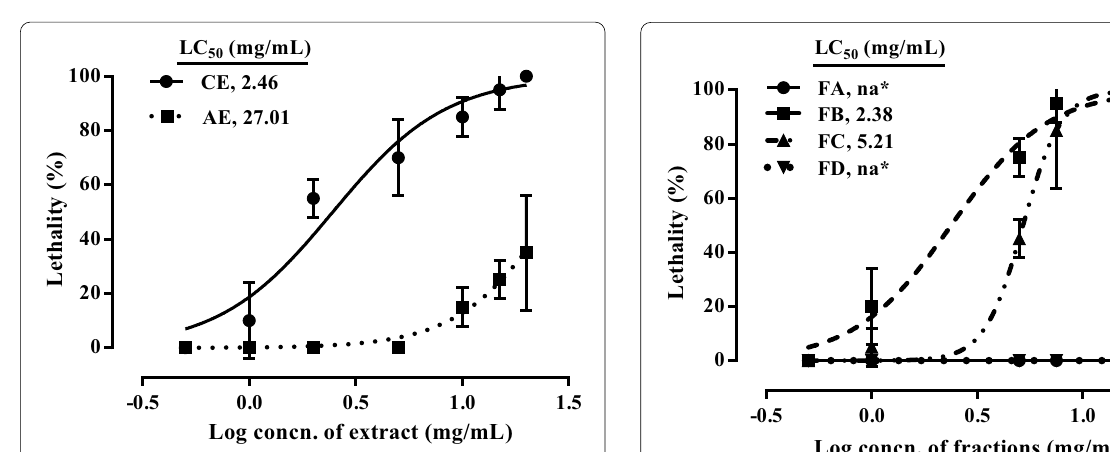
Fig. 5 Anthelmintic activities of FA-FD, obtained by vacuum liquid chromatographic fractionation of Vernonia amygdalina chloroform extract. Each value represents two replicates of two